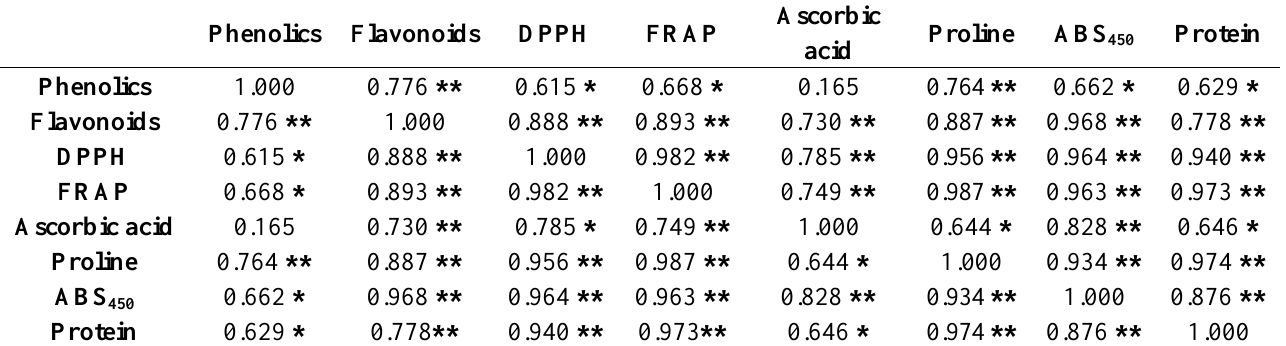
Table 4. Correlation matrix showing the interrelation among phenolics, flavonoids, DPPH scavenging, FRAP, ascorbic acid, proline, ABS and protein. 450 Phenolics Flavonoids DPPH ABS